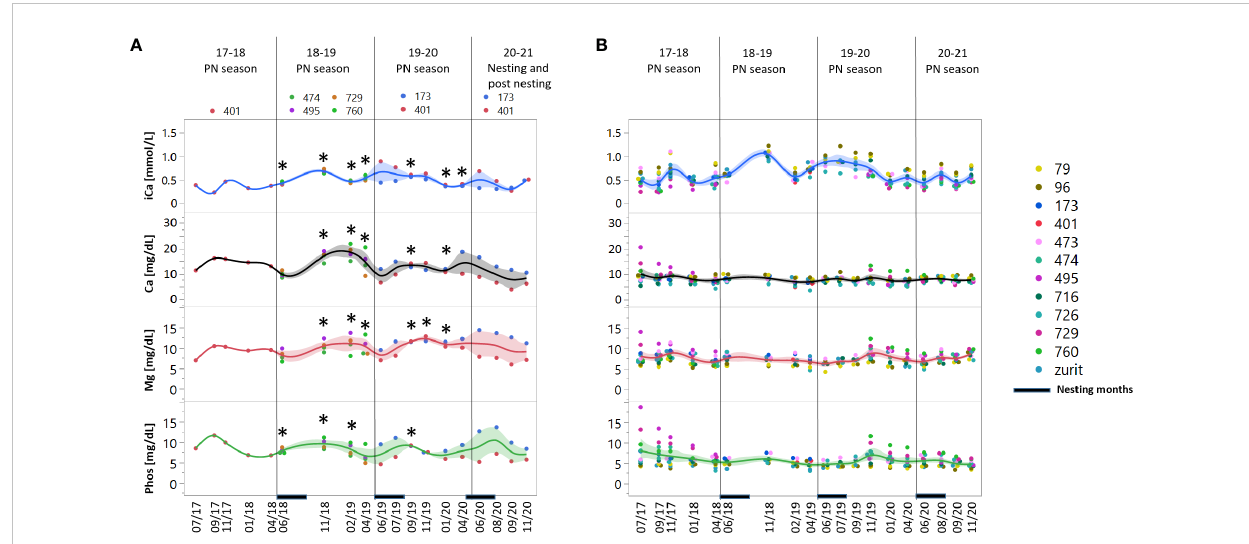
FIGURE 3 Concentration measurements of elements and electrolytes: ionized calcium (iCa), calcium (Ca), magnesium (Mg) and phosphate (Phos) in female green turtles, (A) Future nesters (FN) and (B) Non nesters (NN). Measurements are represented for 19 sampling dates in the period of 2017-2020 divided to 3 pre-nesting (PN) seasons: 17-18, 18-19 and 19-20, and the last nesting/posting season, the nesting period marked at the X axis. At the left panels, asterisk represents signi fi cant difference between the two groups p= 0.05. Shaded areas represent the con fi dence of fi